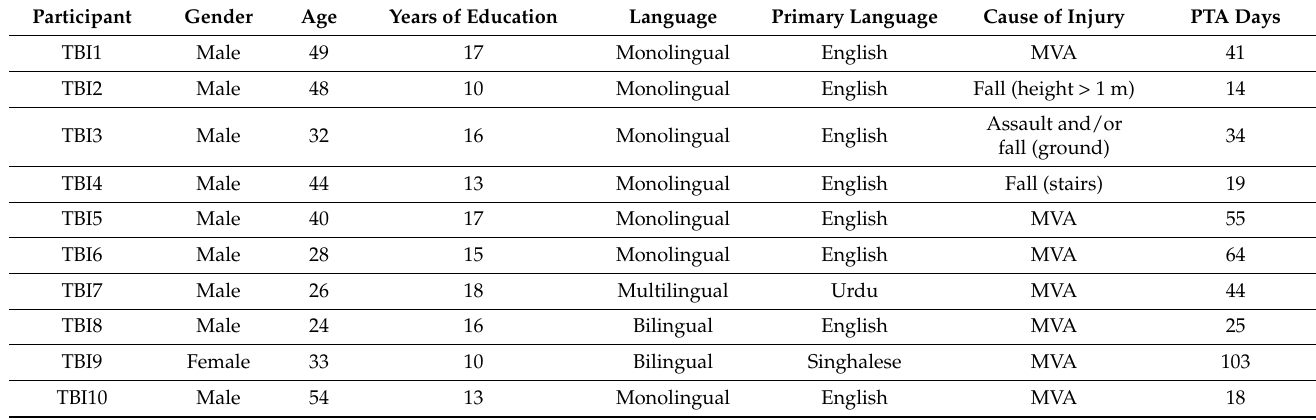
Table 1. Demographics of participants with TBI.